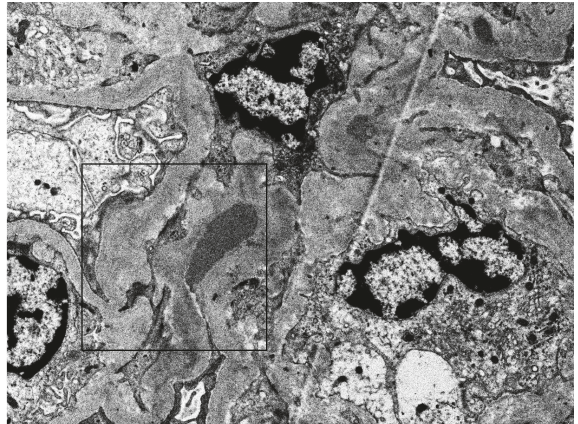
Figure 4: Kidney Biopsy Electron microscopy. Small subepithelial electrondensedepositshowninthemesangialnotch(box)(Electron